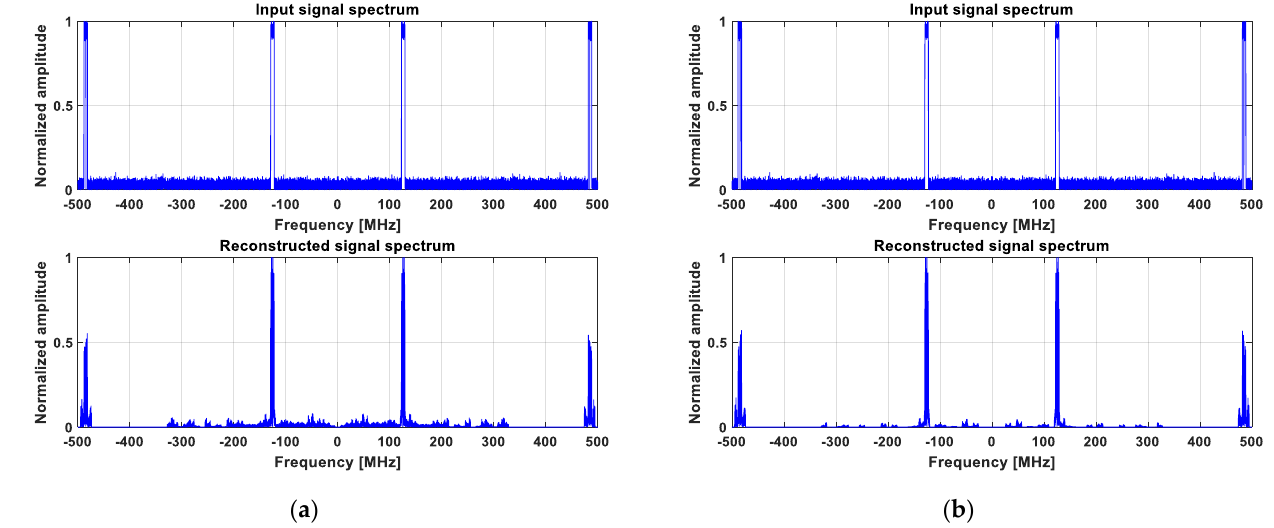
Figure 12. Wideband spectrum sensing results provided by the proposed reconstruction algorithm for two active transmitters: ( a ) Original measured data; ( b ) Reduced data.